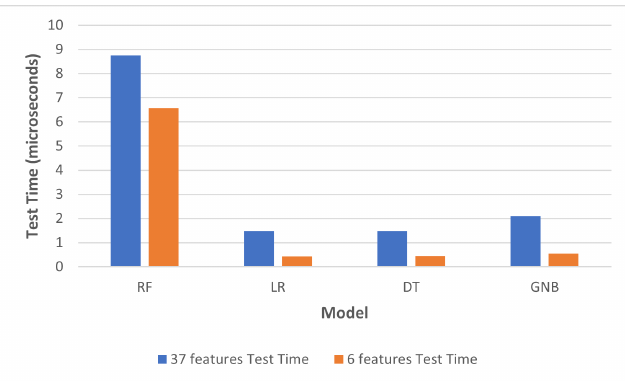
Figure 8. Change in testing time after feature reduction.